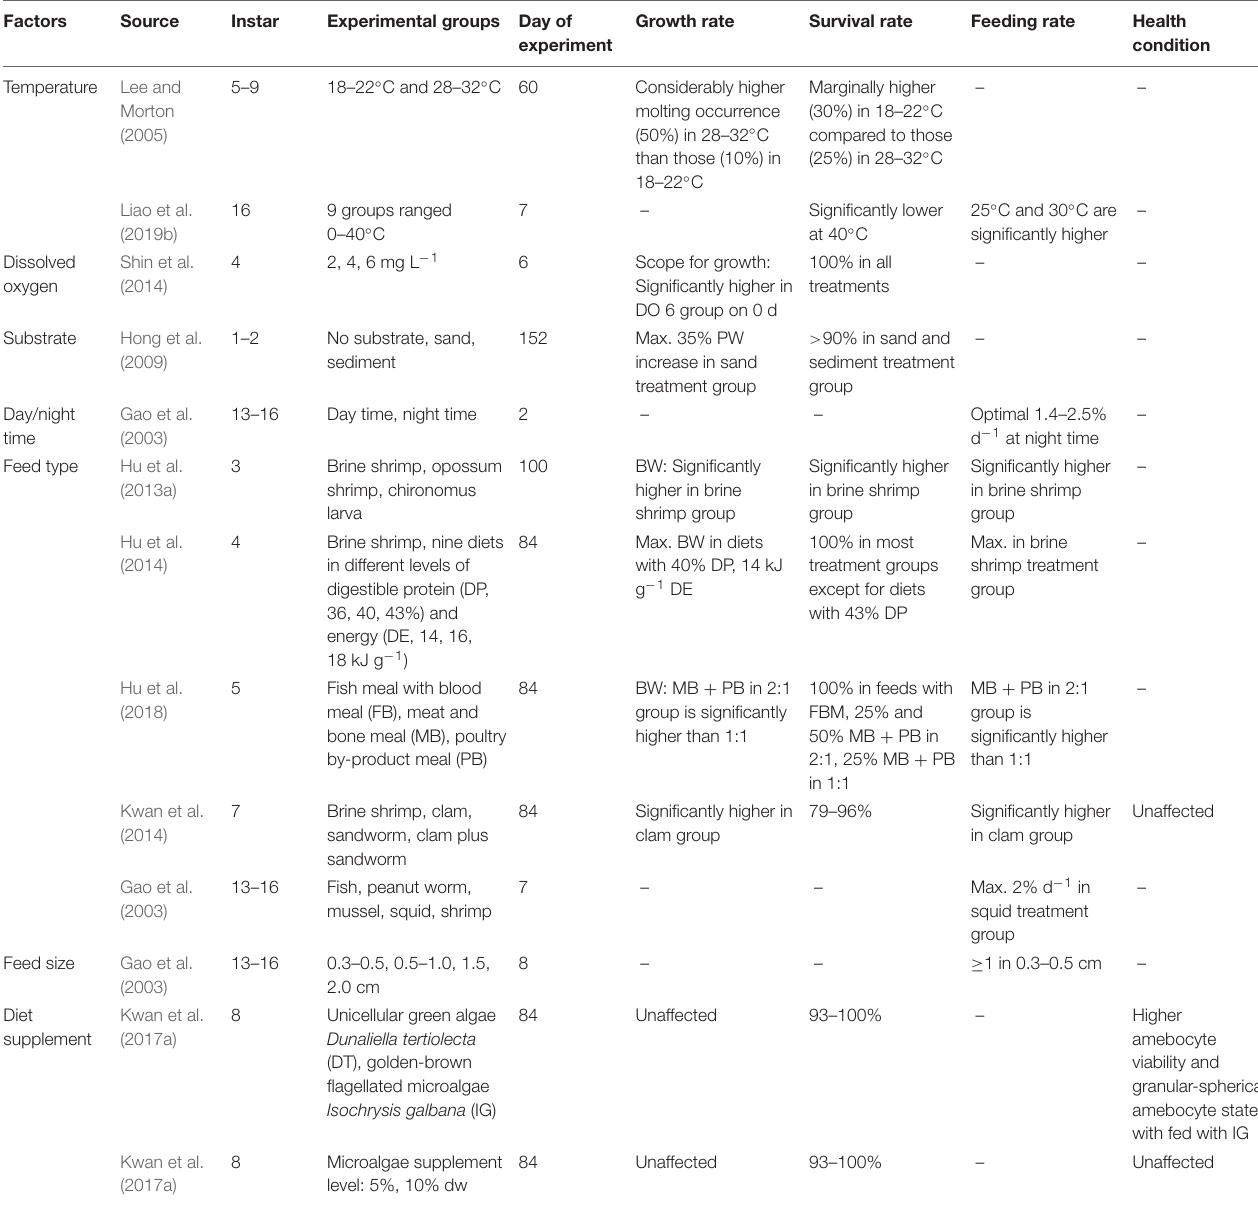
TABLE 2 | Effects of various environmental factors and diet conditions on optimal growth, survival and health status of juvenile T. tridentatus in culture